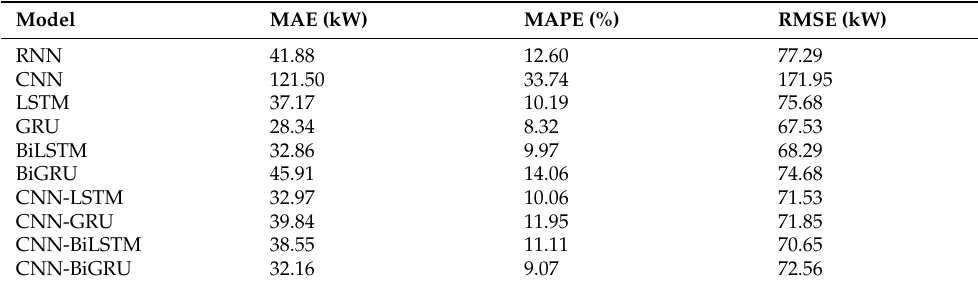
Figure 8. Performance comparison of the single model with one-day PV generation data on a regular weather day. Table 4. MAE, MAPE, and RMSE values for one-day PV generation forecasting on a regular weather